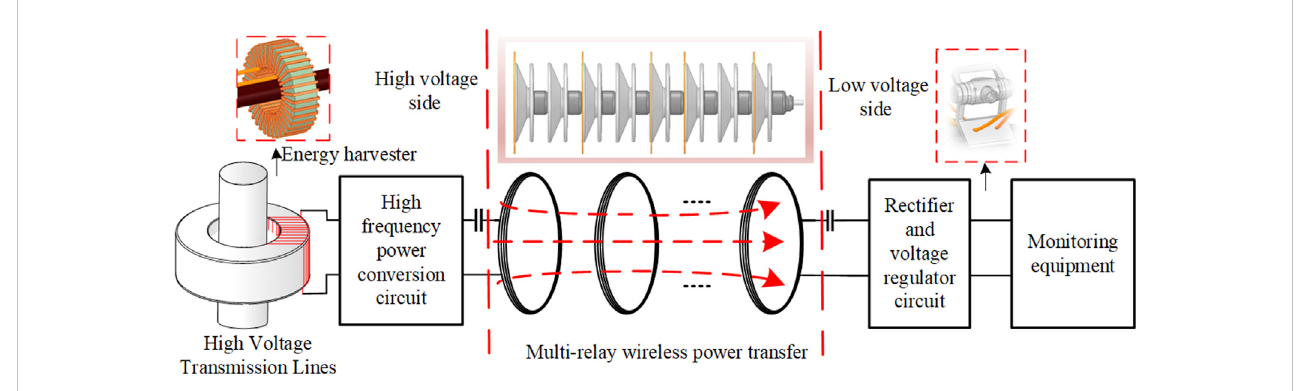
FIGURE 1 WPT system of transmission tower on-line monitoring